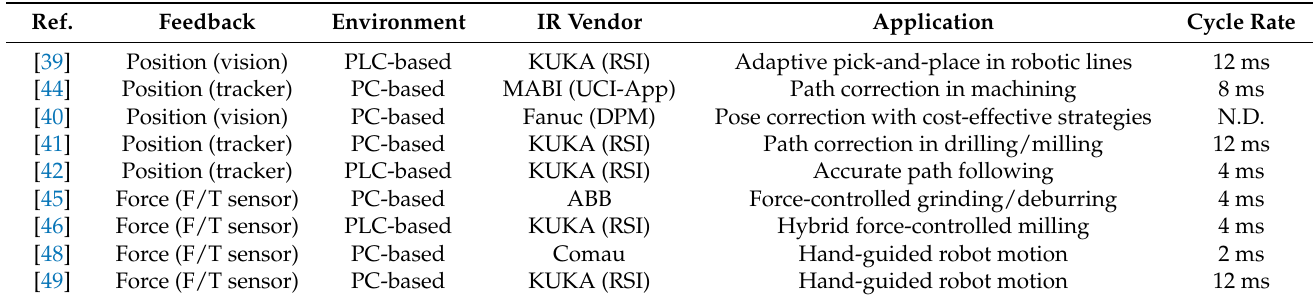
Table 3. Examples of external trajectory generators from